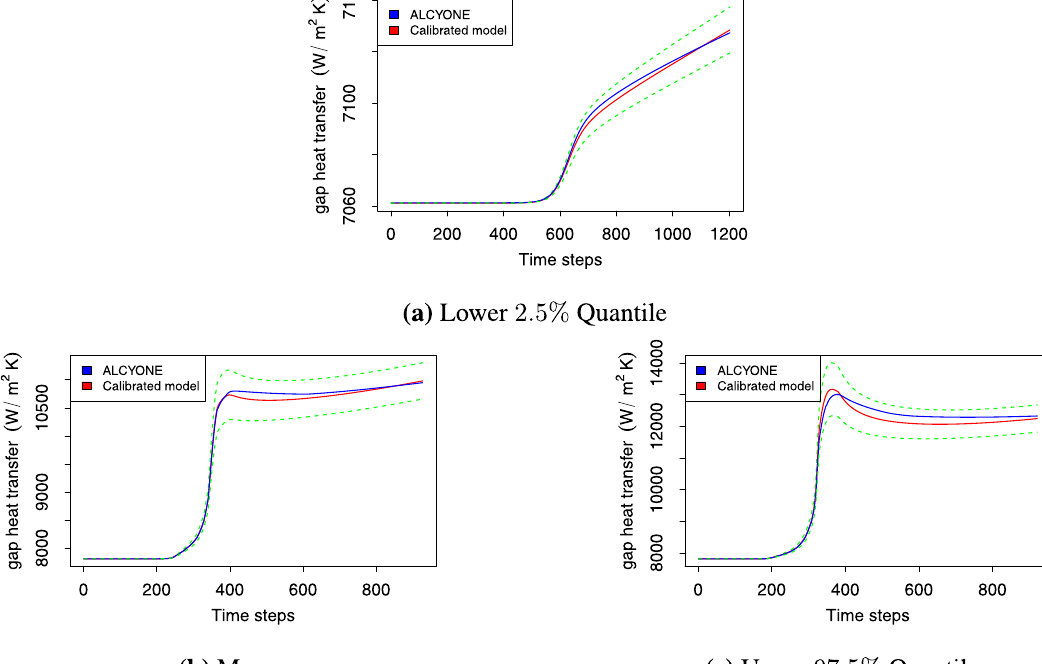
Fig. 11. 30 GWd / t H gap model prediction with its uncertainty bounds in